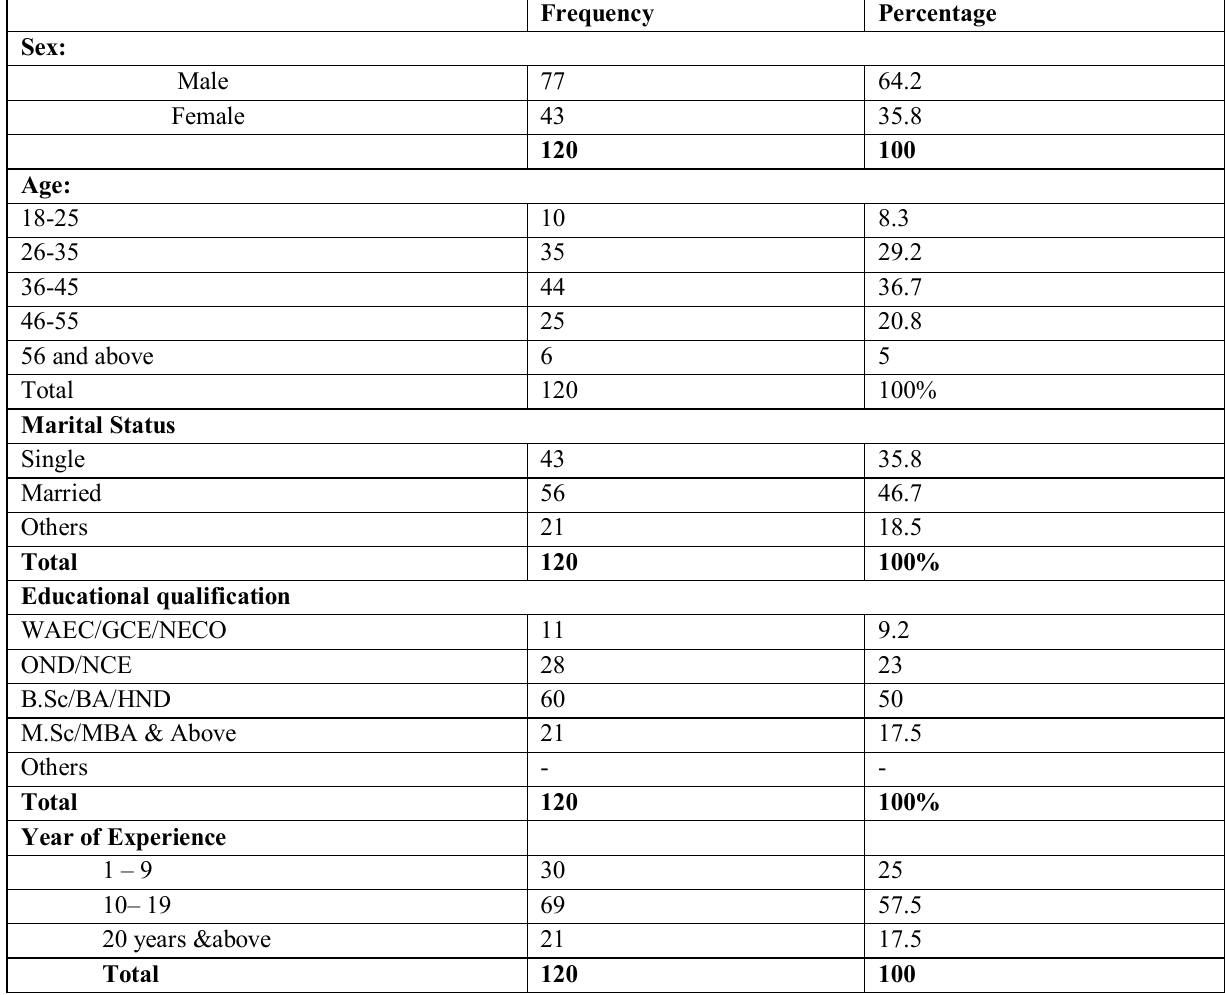
Table 1: Demographic and Socio-economic Characteristics of